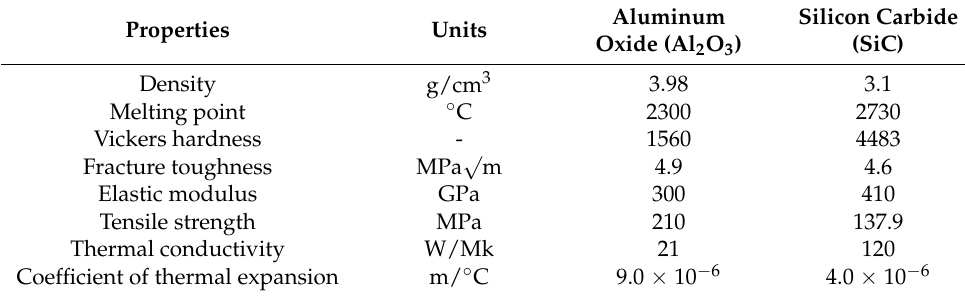
Table 3. General properties of the